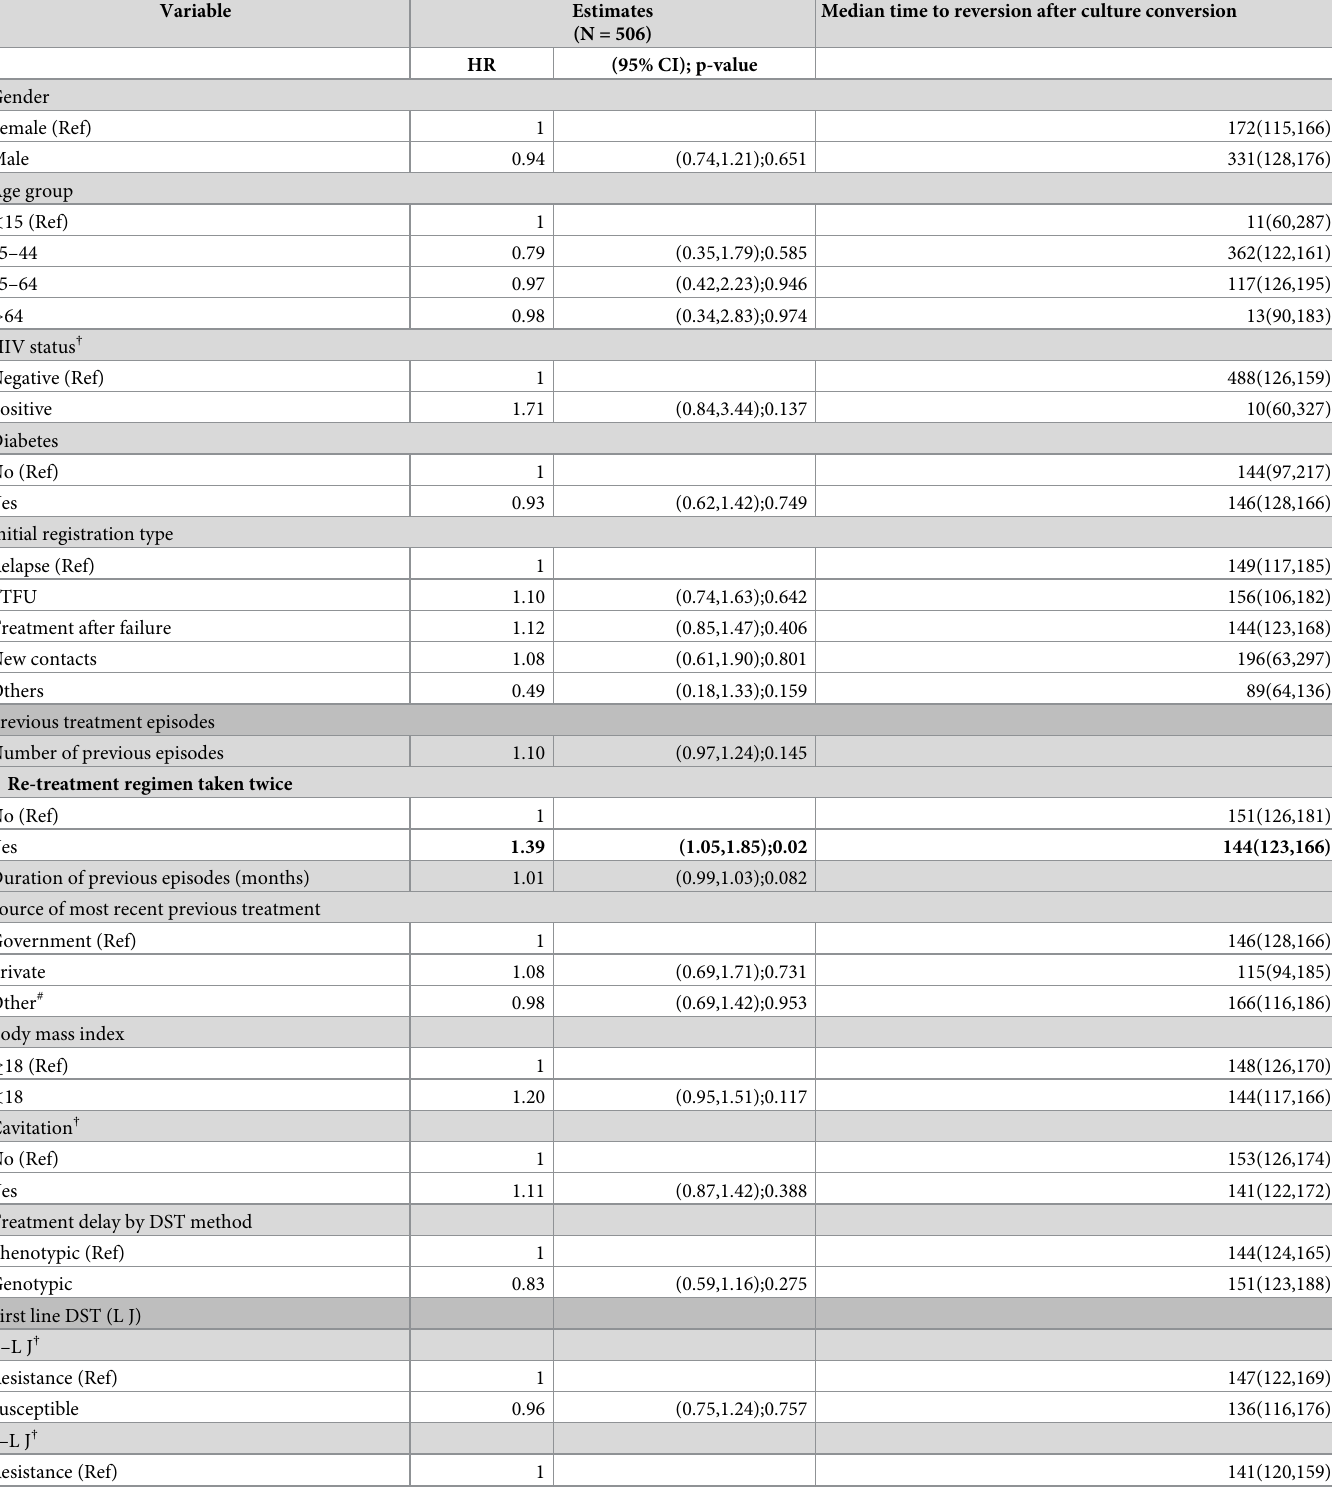
Table 3. Factors significantly associated with culture reversion with bivariate regression model. (Note: HR value > 1 means higher hazard of reversion after culture conversion (negative event/outcome).